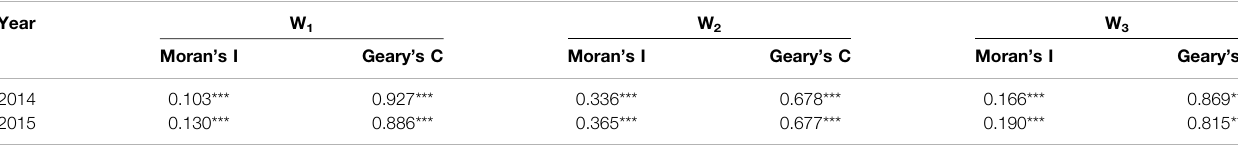
TABLE 3 | Global spatial